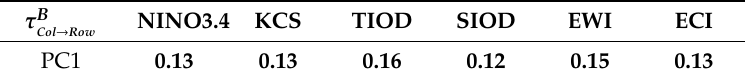
Table 4. IF τ B values between PC1 and the SST indices-based predictors (bold font indicates Col → Row statistically significant values at the 5%